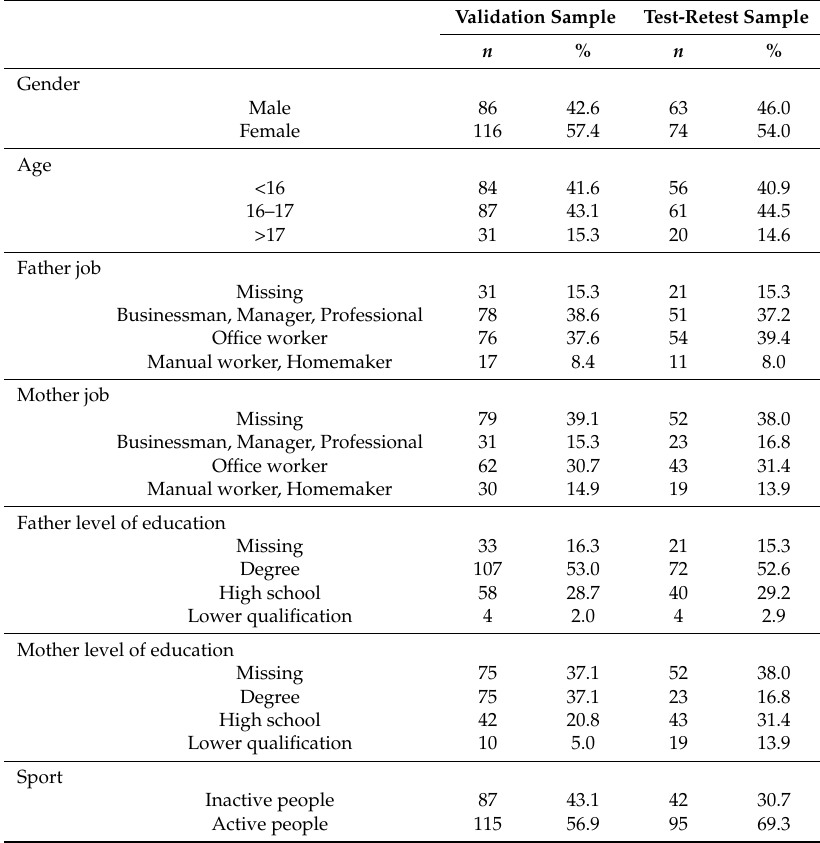
Table 1. Validation sample ( n = 202) and test-retest sample ( n = 137)